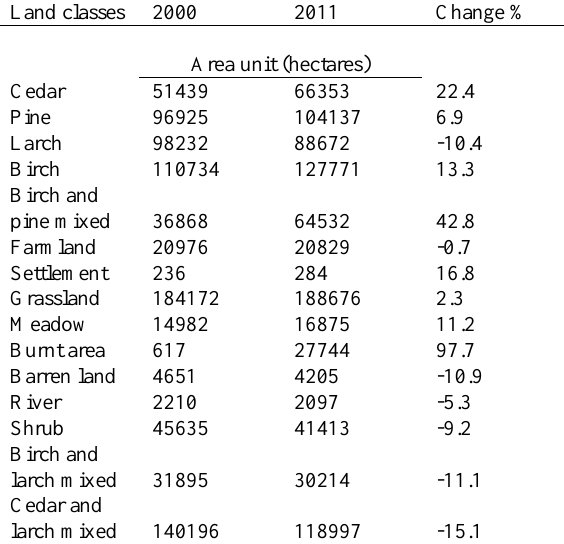
Table 2. Change of forest types